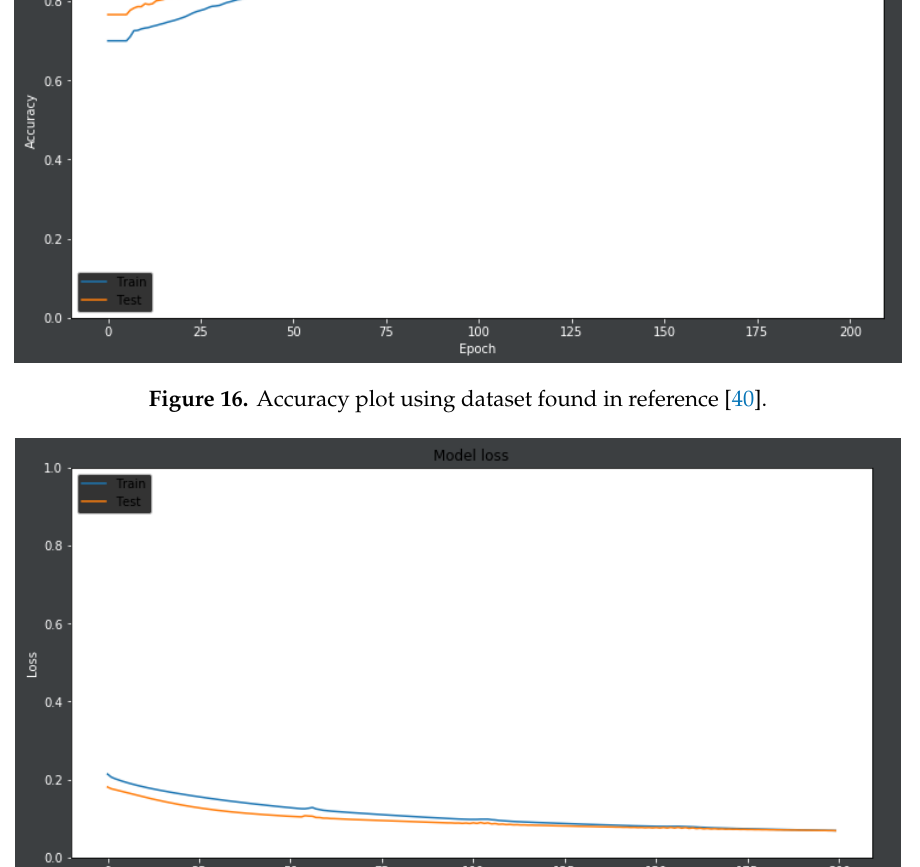
Figure 17. Loss plot using dataset found in reference [40].